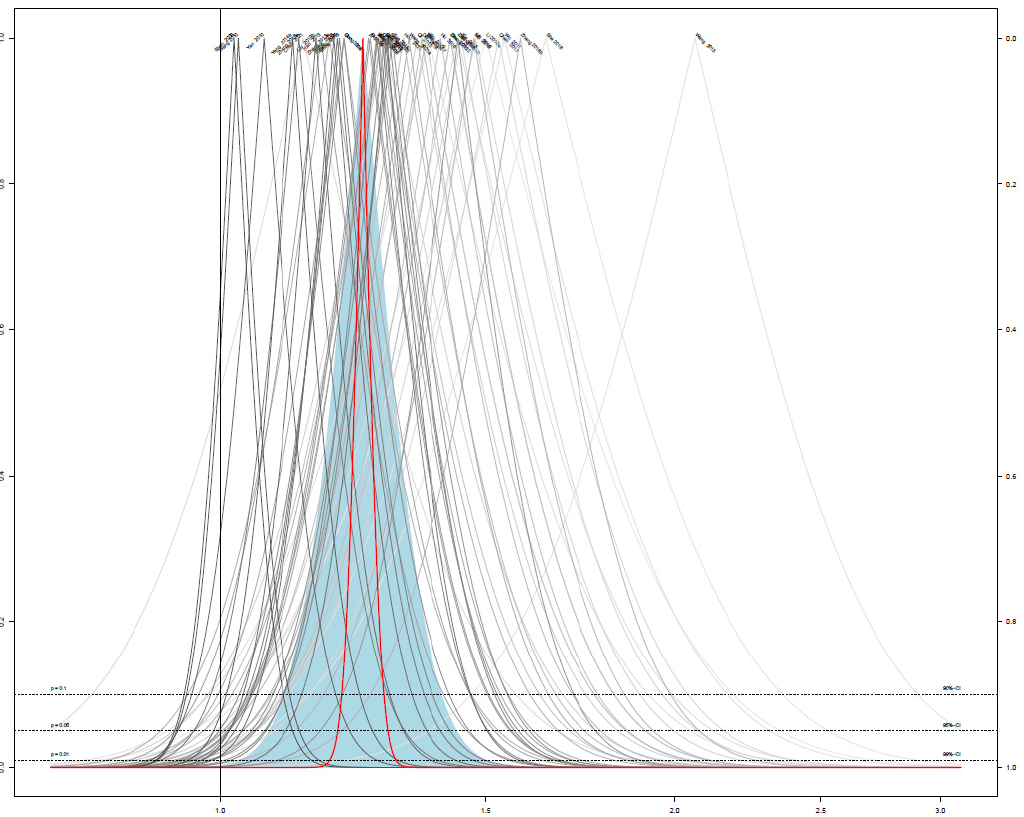
Figure 9. Drapery plot of the trials reporting the effect of East Asian herbal medicine monotherapy on the response rate for peripheral neuropathy.